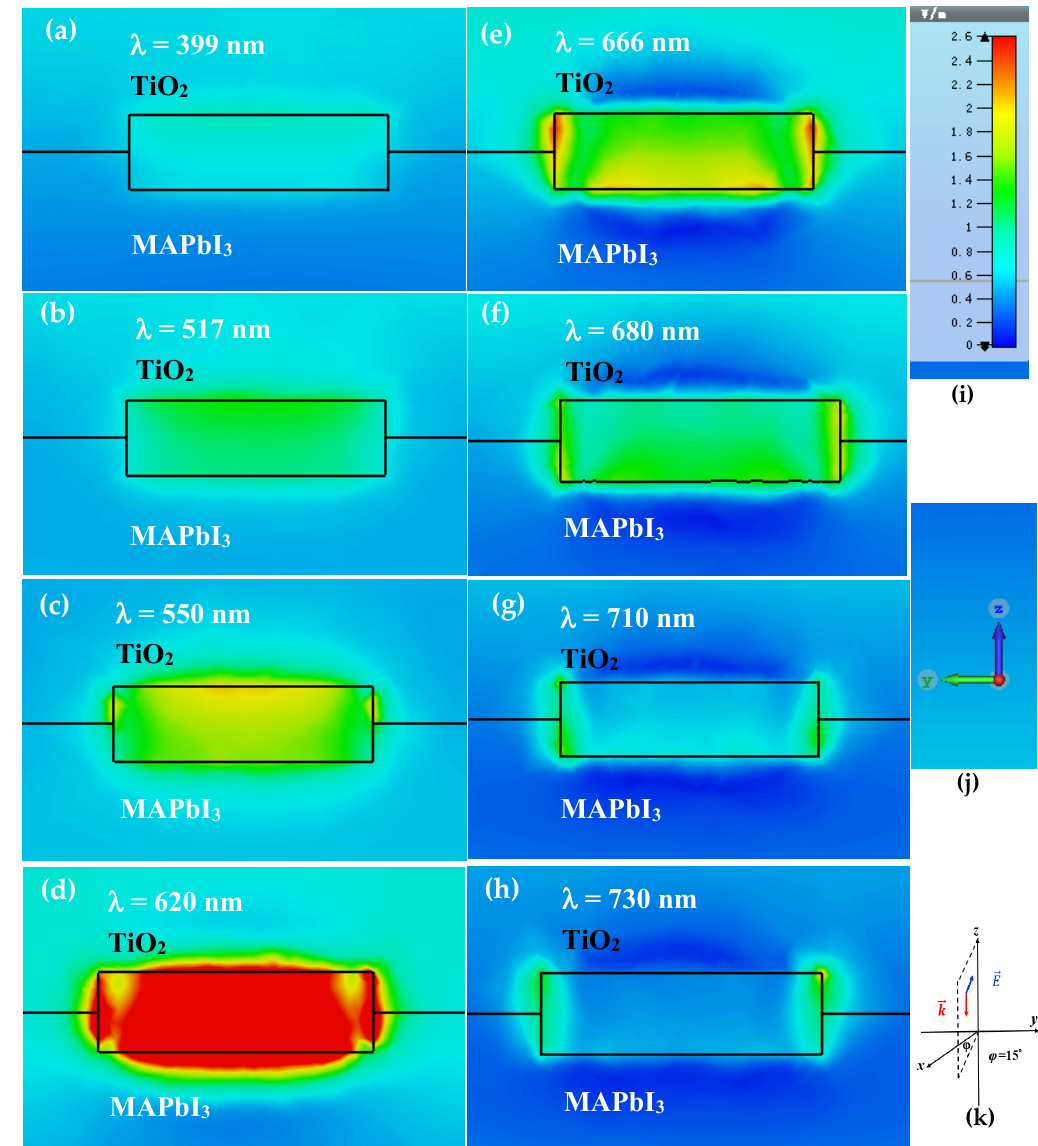
Figure 5. ( a–h ) Simulated field | E | enhancement factor distribution around Au NR (40 nm in length and 11.6 nm in diameter) at different wavelengths, ( i ) color scale and ( j ) yz plane. The local field-enhancement factor distributions on yz planes at x = 0 nm. ( k ) Incident light beam propagation is along – z , and the light polarized direction.